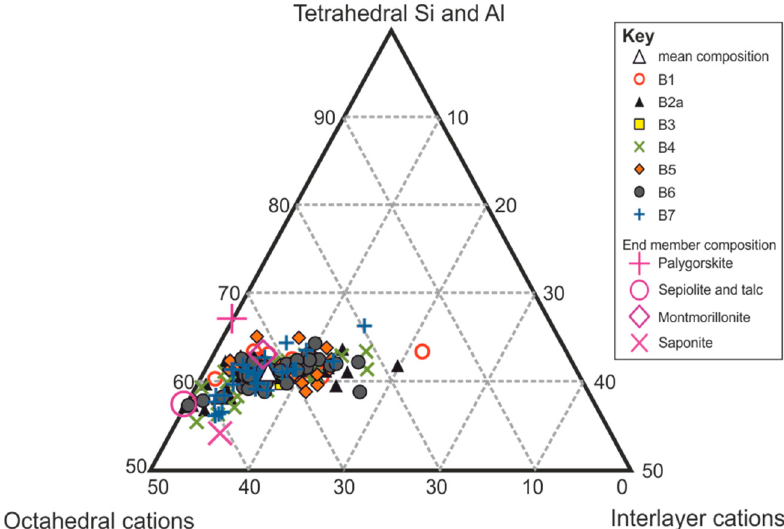
Figure 9. Borehole KM1 triaxial Si—octahedral cations—interlayer cations plot using APFU values. All clay data colour-coded by sample. End member palygorskite, sepiolite, talc, montmorillonite and saponite points included for reference.